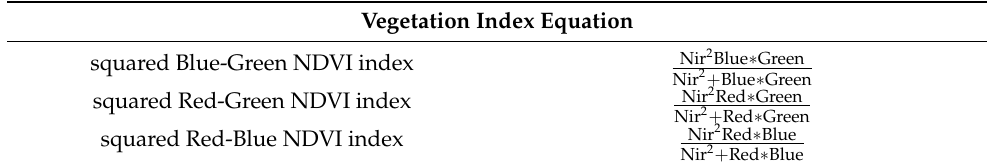
Table 6. A novel vegetation index equation.